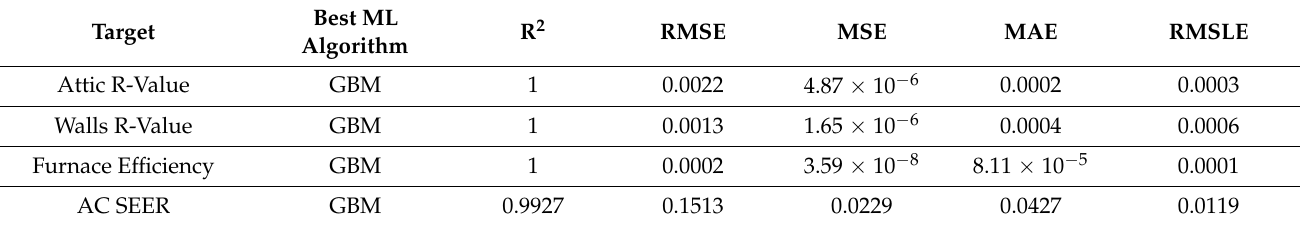
Table 11. Models’ prediction evaluation parameters for validation without using thermostat-derived